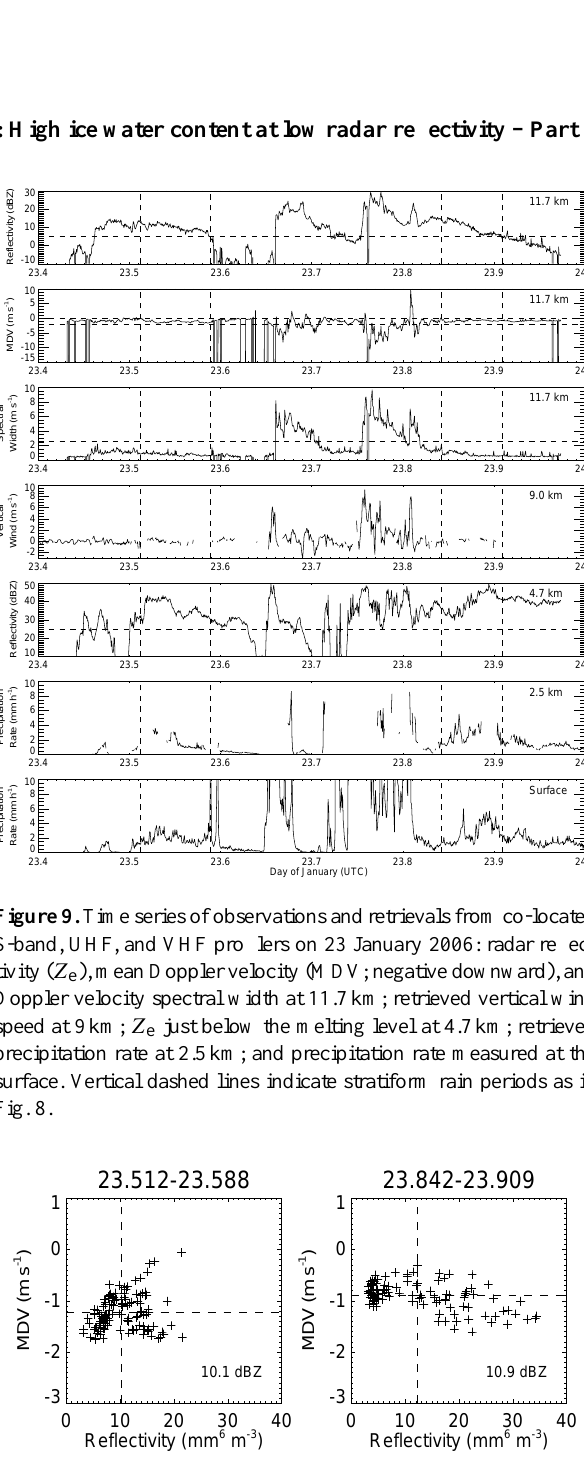
Figure 10. Mean Doppler velocity vs. equivalent radar reflectivity measured by S-band profiler during two stratiform periods shown in Figs. 8 and 9. Dashed lines indicate mean values within each sample; mean reflectivity reported in dBZ units at lower